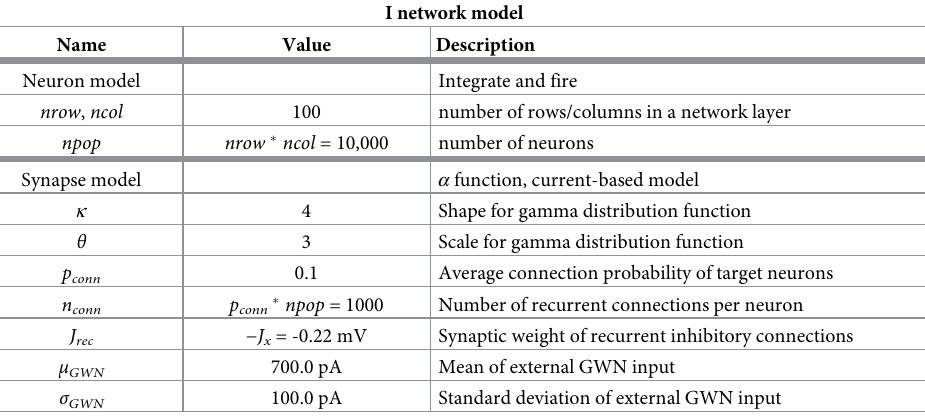
Table 2. Parameter values for the networks (top), for the connections (middle) and for an external input (bottom) in I network